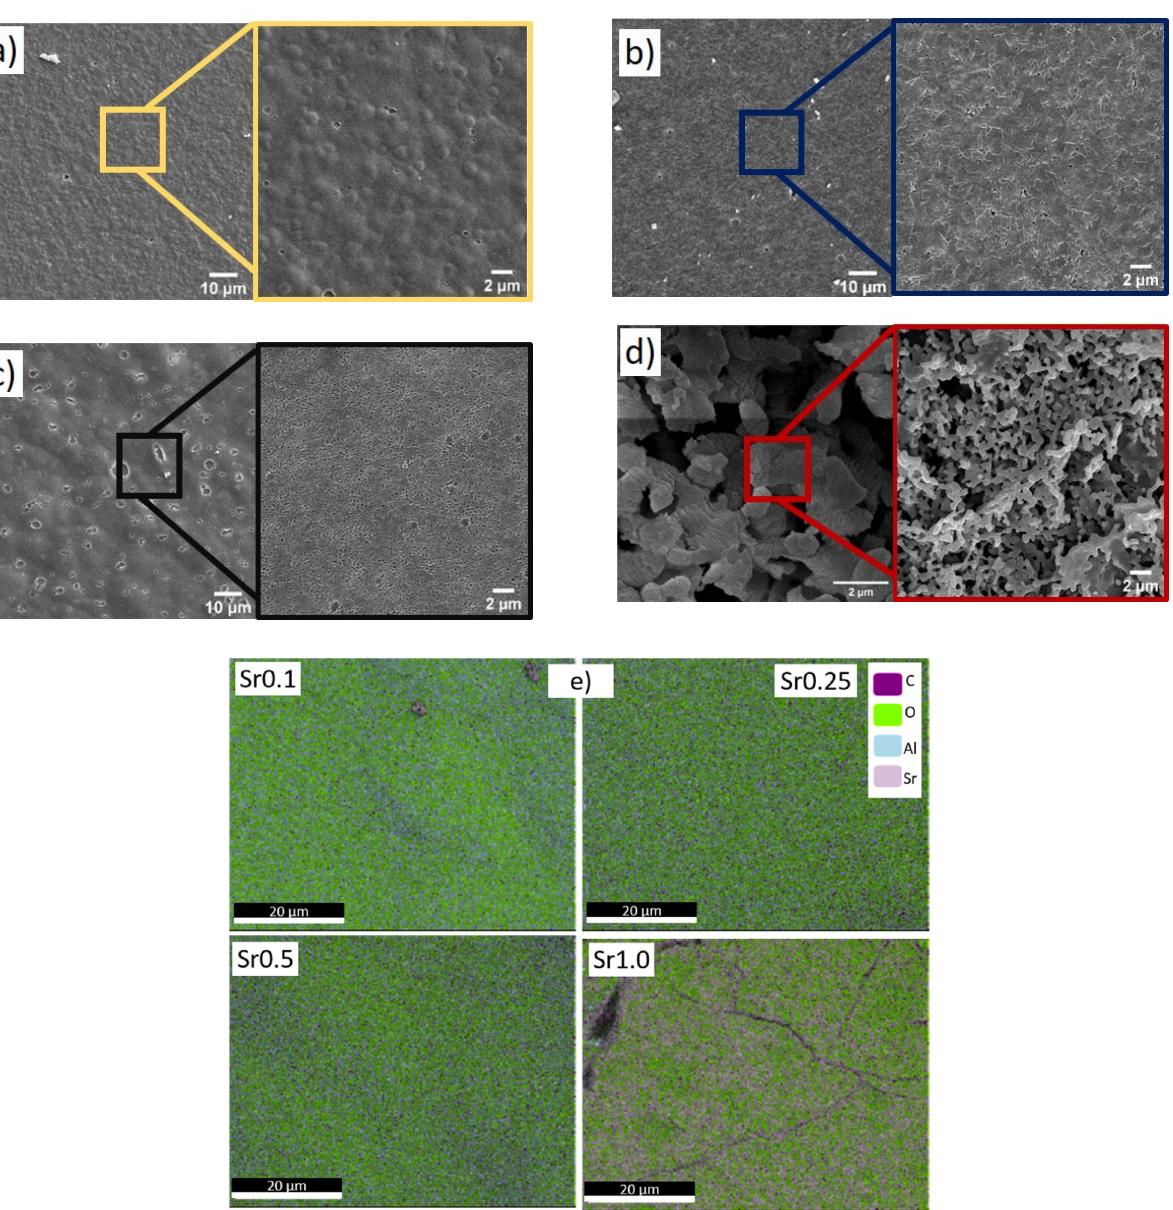
Figure 2. SEM micrographs of the Al 2 O 3 /SrCO 3 xerogels with various molar ratios: ( a ) Sr0.1, ( b ) Sr0.25, ( c ) Sr0.5, ( d ) Sr1.0, and ( e ) SEM-EDS analysis.